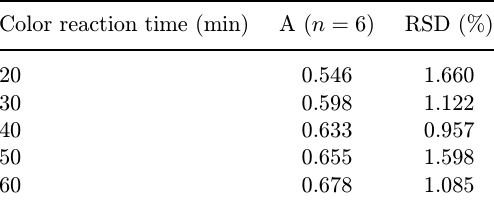
Table 2. Nonadsorbed polyphenol stability test. Color reaction time (min)